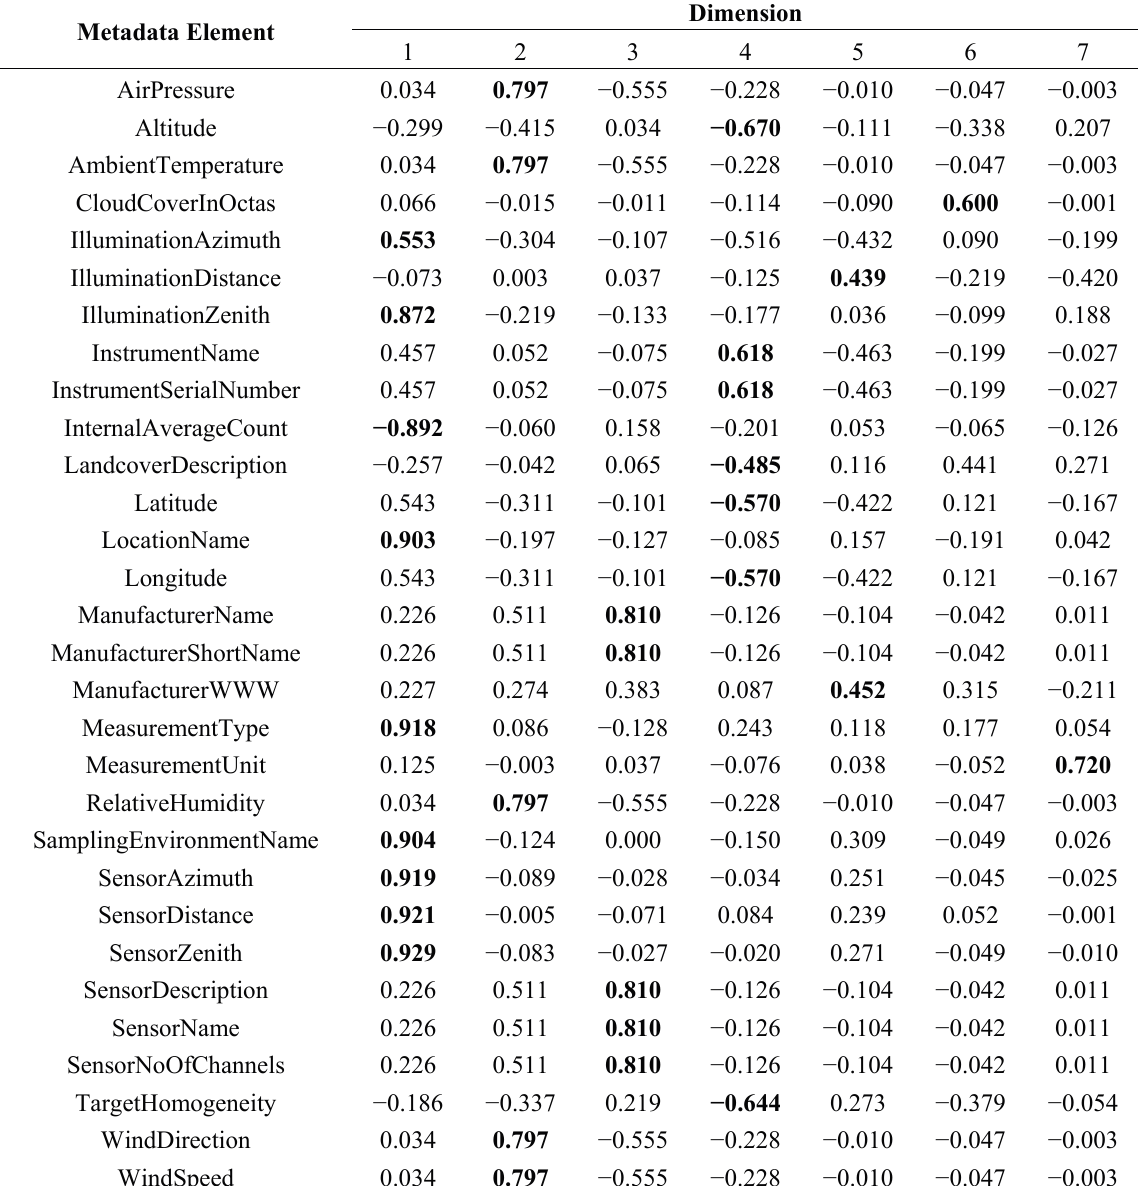
Table 5. Dimension loadings for SPECCHIO spectrum level metadata completeness using categorical principal components analysis with variable principal normalization. The highest loading for each metadata element has been highlighted in